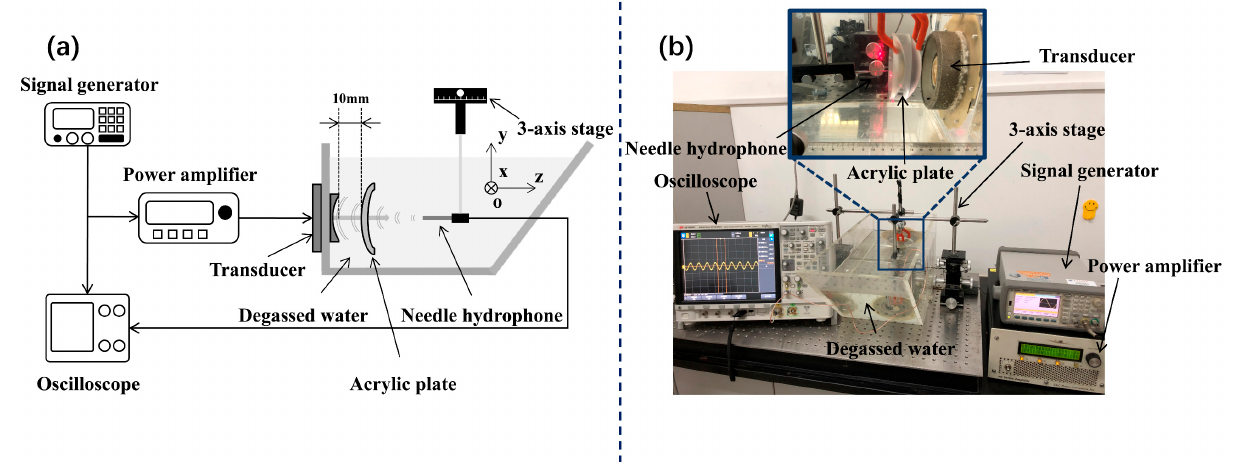
Figure 3. ( a ) Schematic diagram of the experimental setup; ( b ) physical map of the experimental setup.